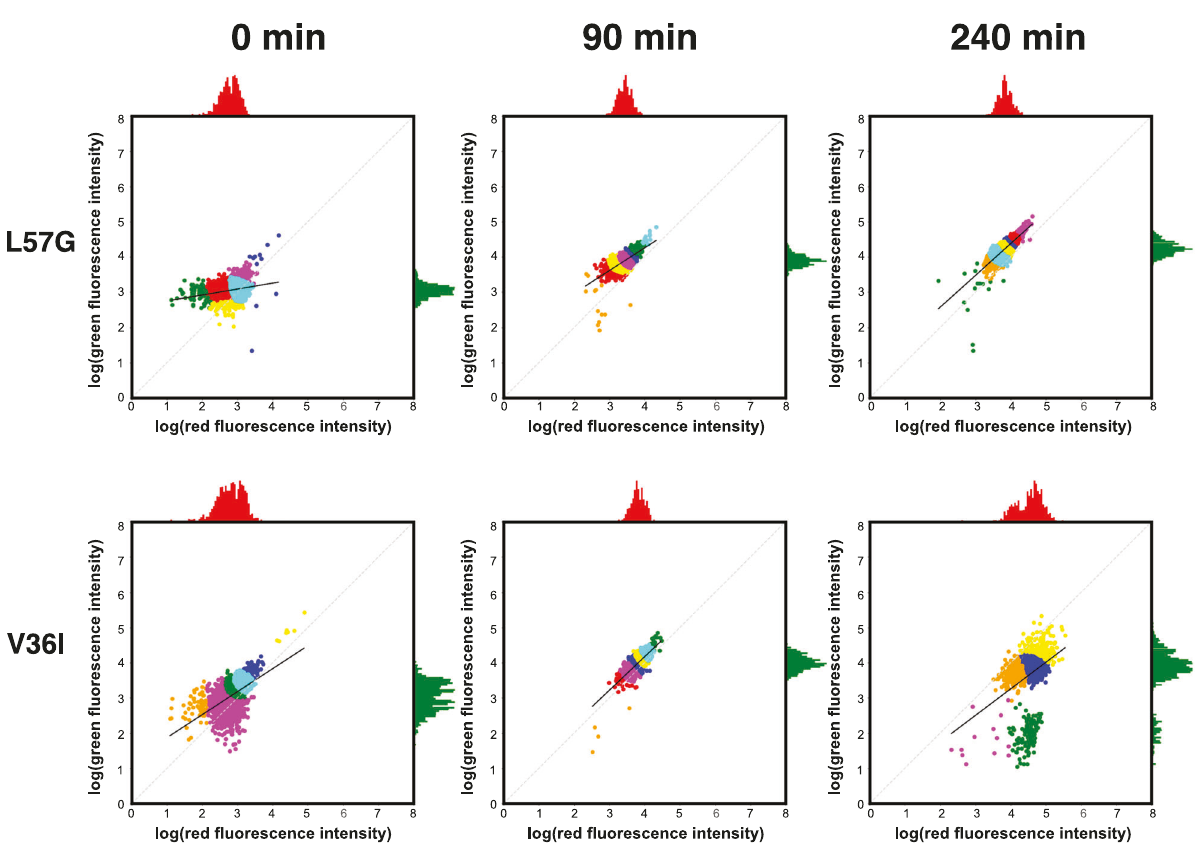
Fig. 6 Red and green fl uorescence of single cells expressing L57G and V36I. The red and green fl uorescence for each individual cell in a population expressing L57G (top) and V36I (bottom) at the time of induction (left) and 90 min (middle) and 240 min (right) after induction with IPTG. Colouring in scatter plot is based on a Bayesian Gaussian mixture model for cluster assignment. The x -axis histogram (red) shows the distribution of red fl uorescence, and the y -axis histogram (green) shows the distribution of green fl uorescence within the